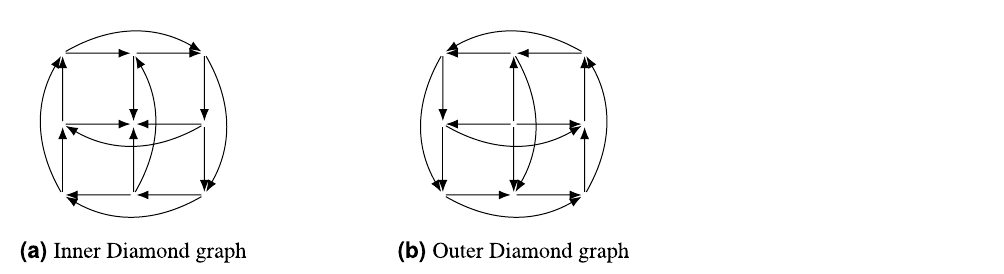
Figure 11. The inner and outer diamond